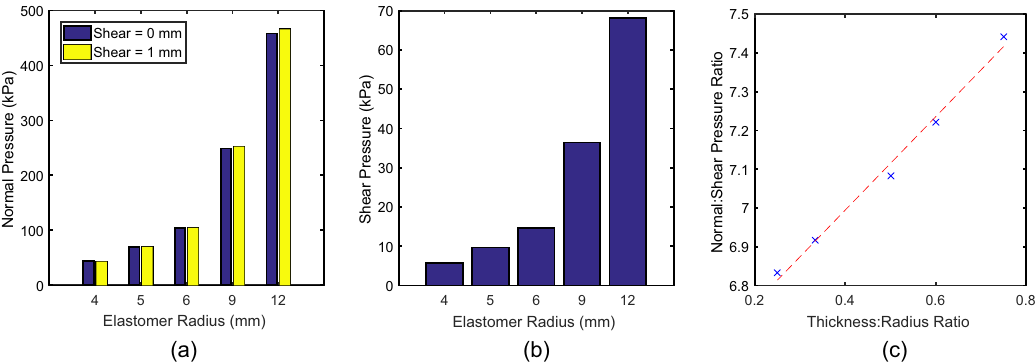
Figure 6. Maximum force output at 1 mm strain in ( a ) normal pressure and ( b ) shear pressure. ( c ) The effects of geometry ratio change on the output force ratio, a linear relationship is